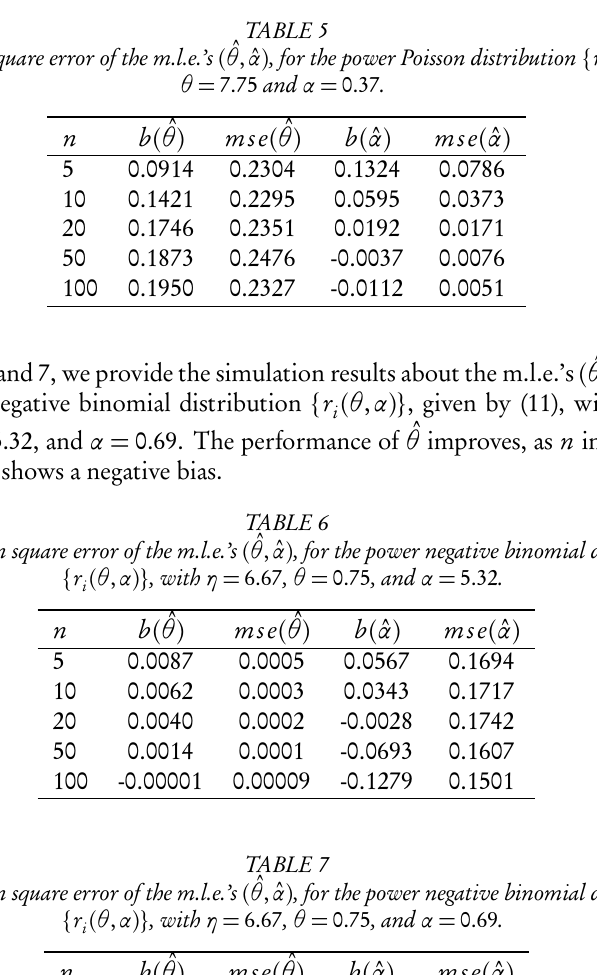
Bias and mean square error of the m.l.e.’s ( ˆ θ , ˆ α ) , for the power Poisson distribution { r